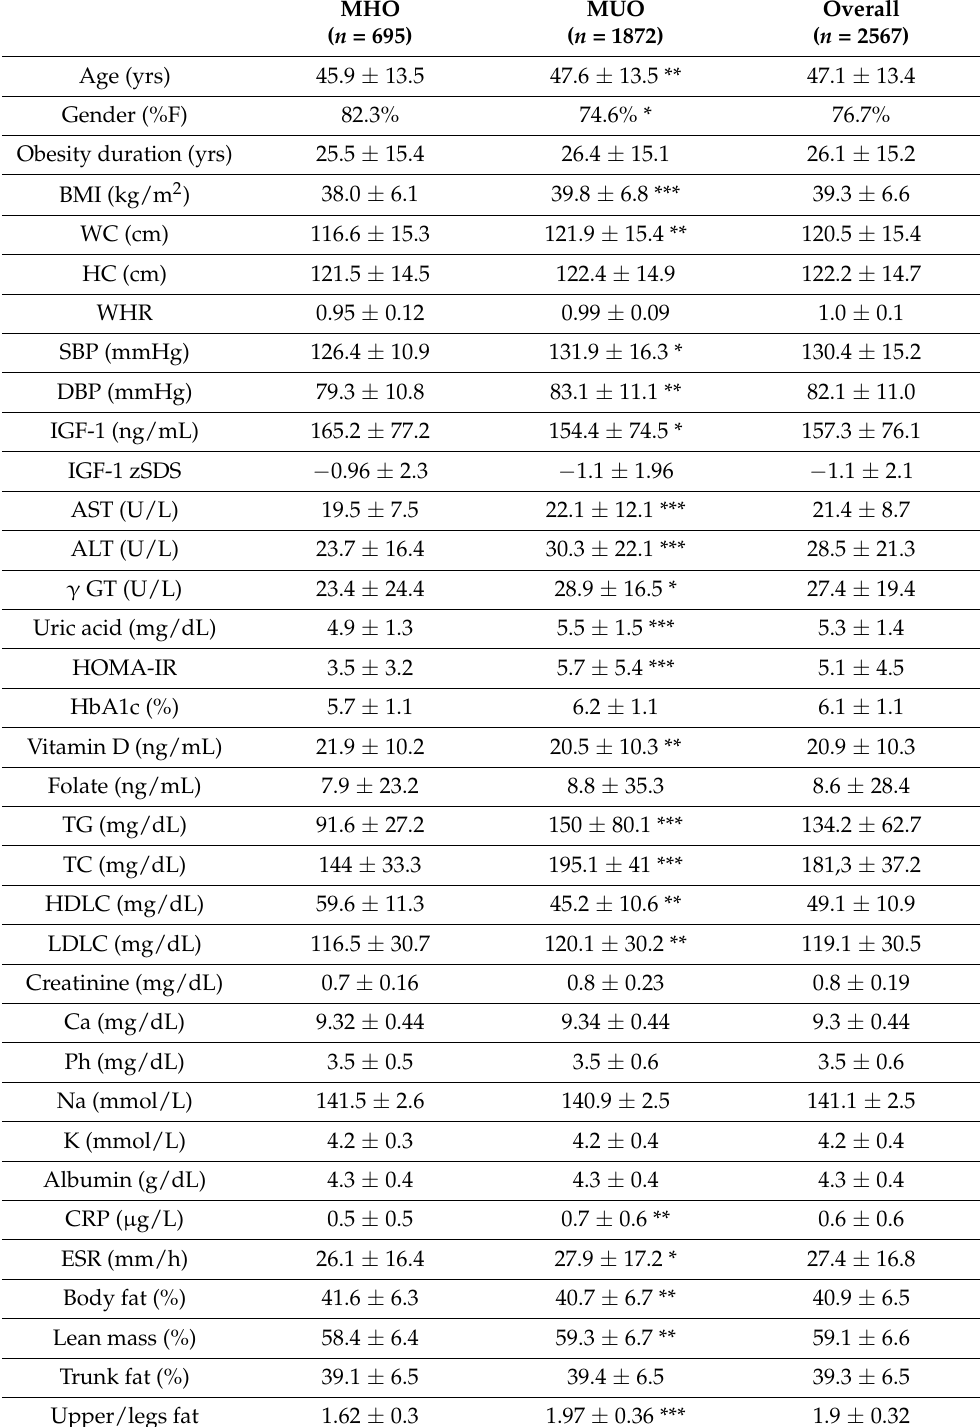
Table 1. Baseline characteristics of study population included in the ML analysis, broken down by presence/absence of metabolic